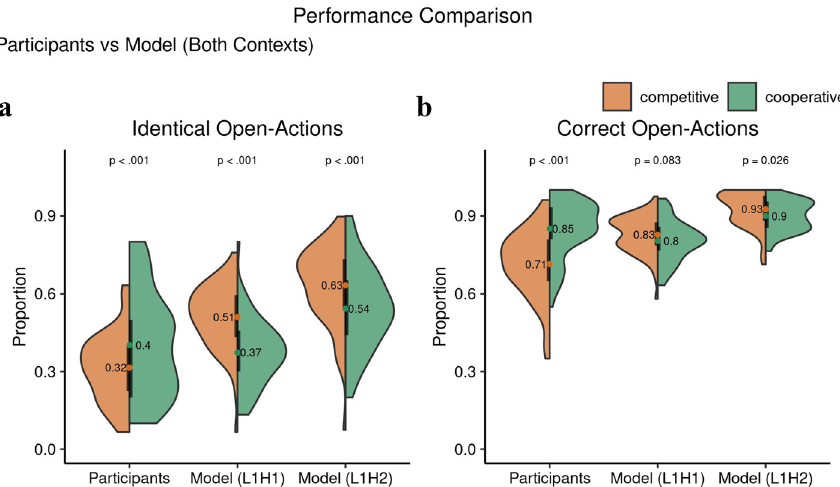
Figure 9. Interactive choice behavioral indices’ (identical and correct open actions) comparison of the multiagent version of the ITT between participants and IPOMDP models, competitive and cooperative contexts. The figure shows the mean values with their distributions in the form of split violin plots. The black bars cover the interquartile range. In ( a ) we observe that identical open actions are significantly higher in cooperative context for participants, however in the IPOMDP models it is higher in the competitive context. In ( b ) comparing the correct open actions we observe similar behavior for the participants and the IPOMDP model L1H2, however for the Model L1H1 there is no significant difference between the